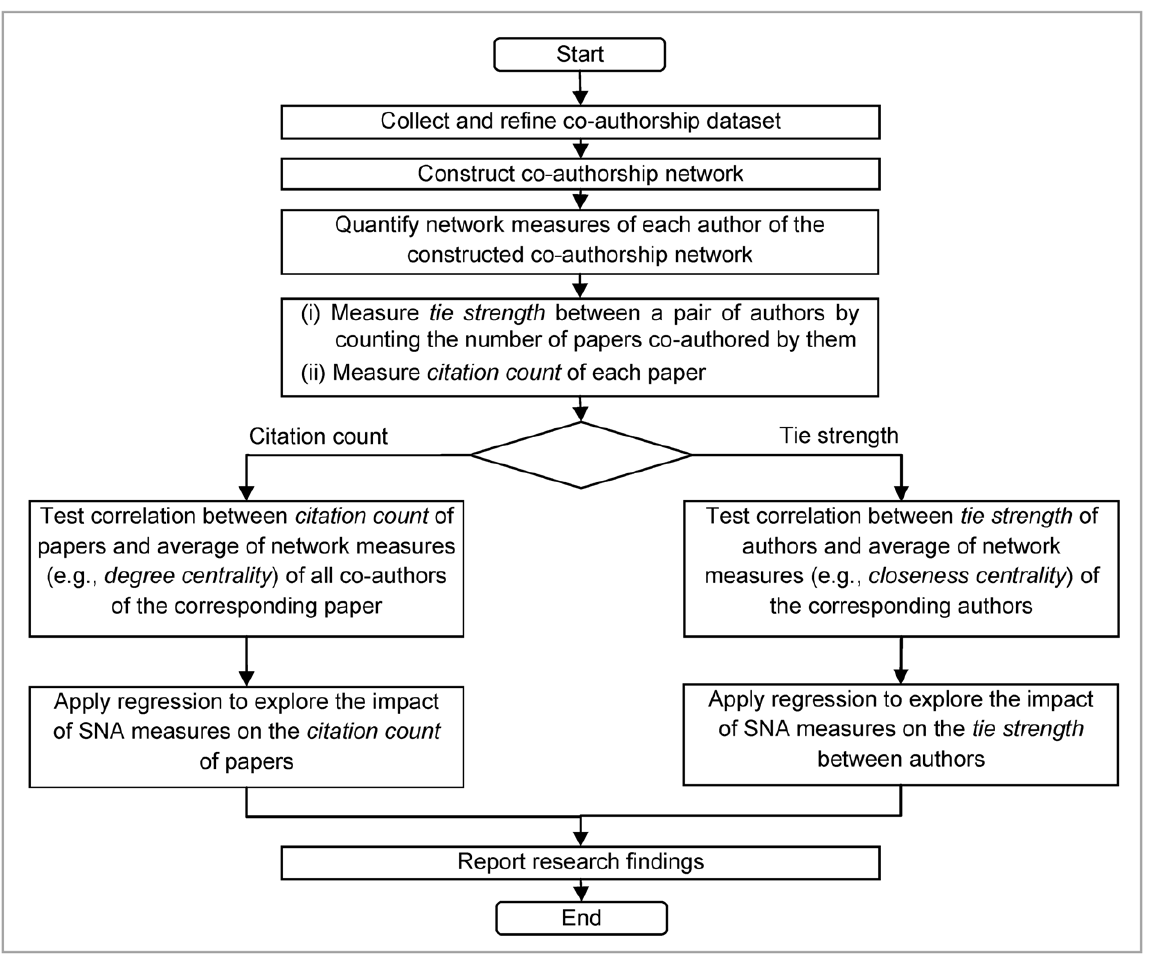
Figure 3. Research analysis process.